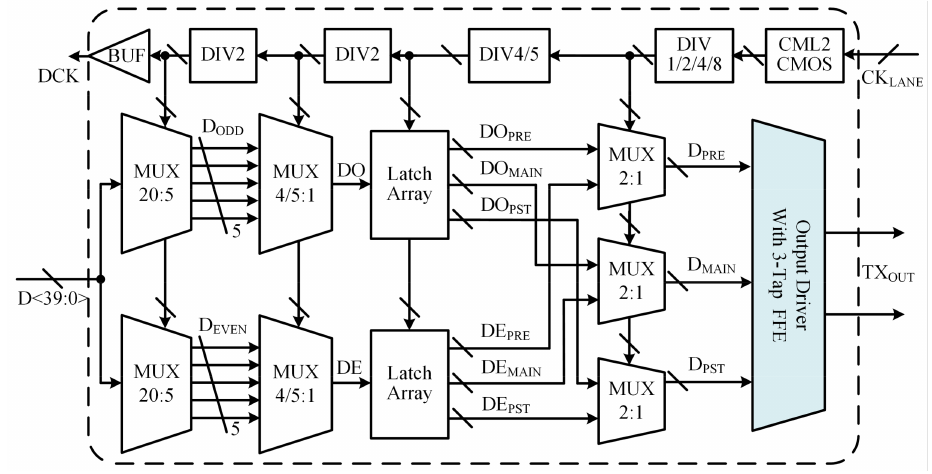
Figure 2. The implementation of the proposed multi-rate single